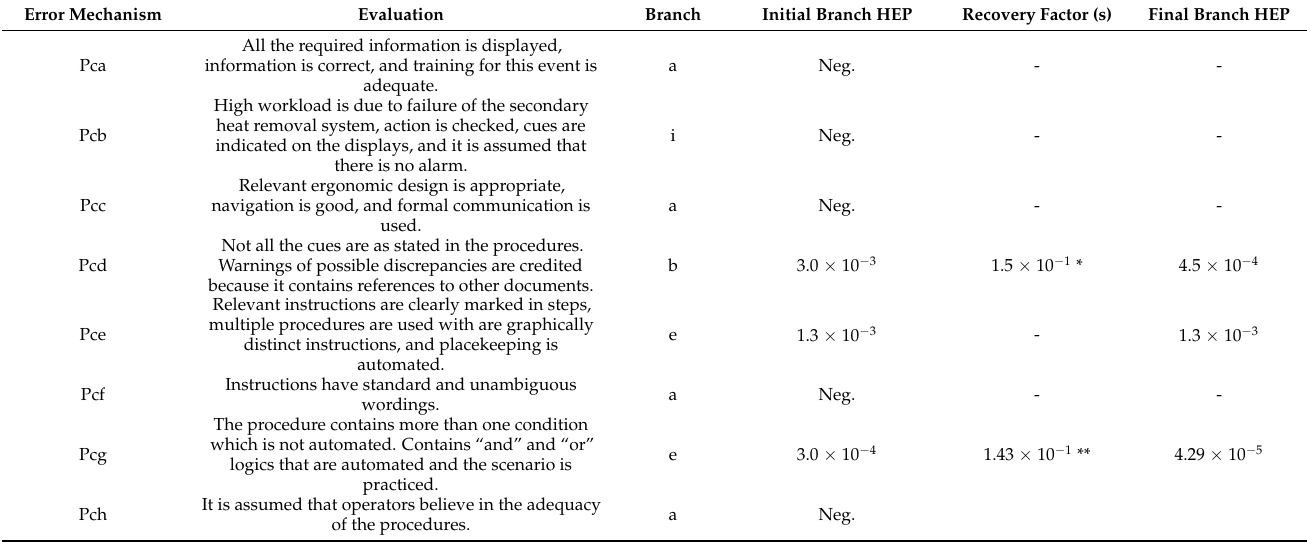
Table 12. Evaluating the diagnosis error for core heat removal in early feed and